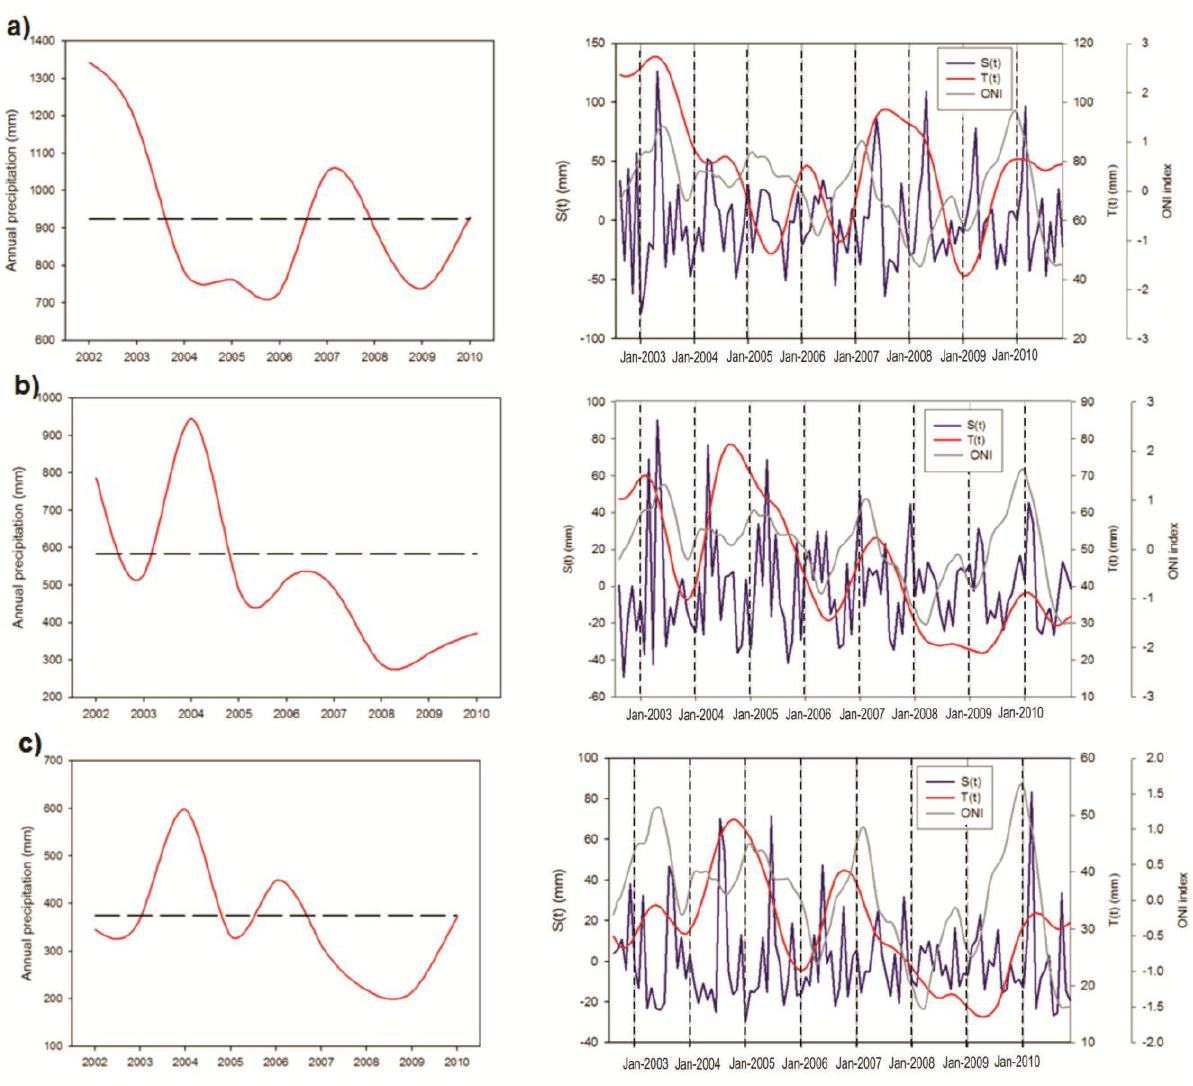
Figure 11. Precipitation variability between 2002 and 2010. The left column is for the total annual precipitation ( in situ ) (red line) and the mean historical precipitation (dashed line). Right column stands for the Census X-11 statistics and the ONI. ( a ) Northeast station; ( b ) Center station; and ( c ) Southwest